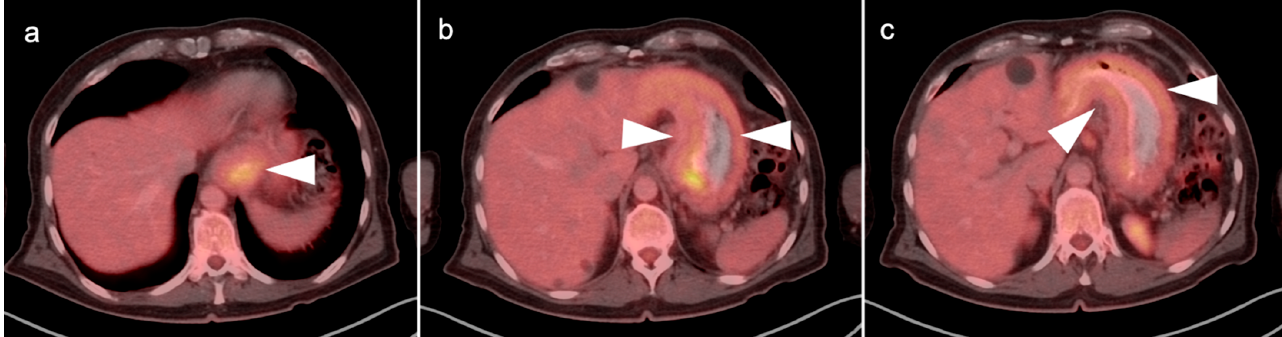
Figure 11. Linitus plastica. ( a – c ) Diffusely thickened, featureless “leather bottle” gastric configuration, mildly hypermetabolic, as shown on axial fused FDG PET-CT images due to diffuse infiltrative adenocarcinoma of the stomach (white arrowhead).